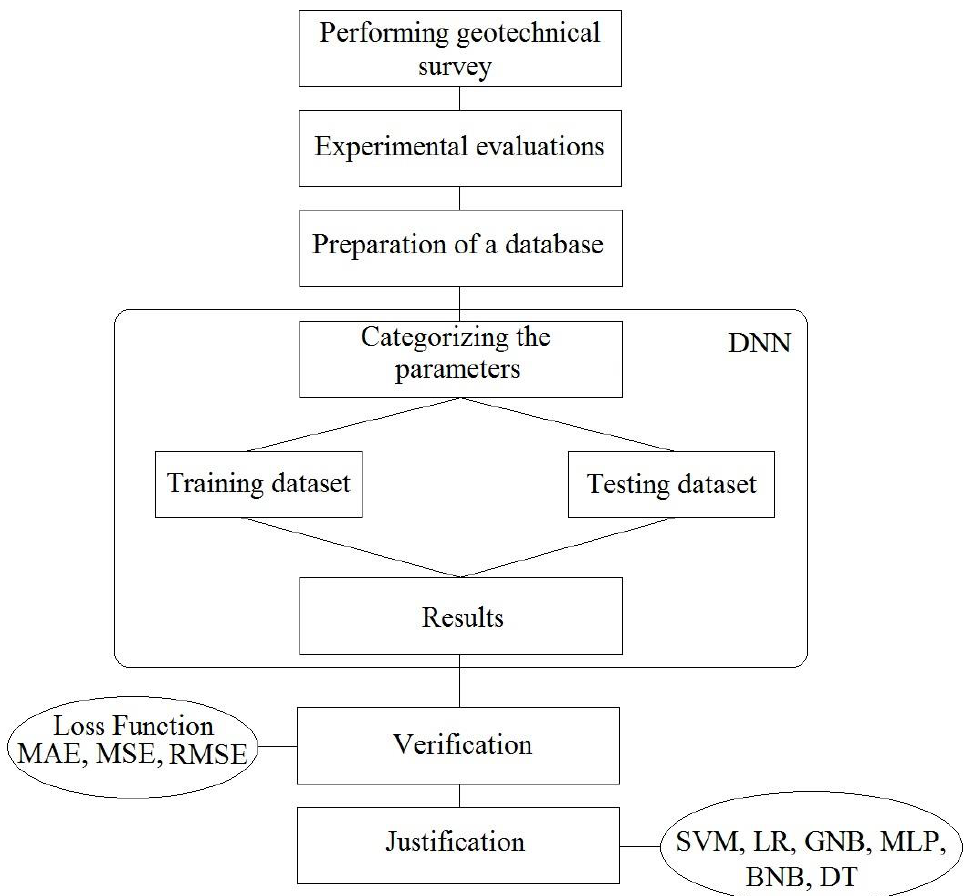
Figure 4. The implemented DNN model flowchart.